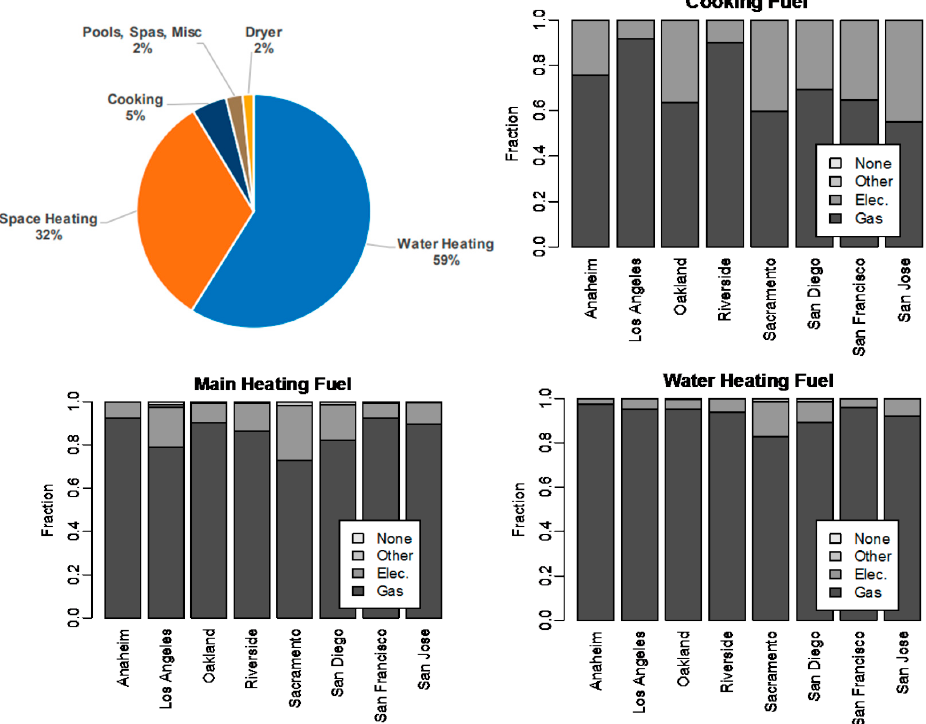
Figure 12. Energy-consumption status by residential appliances in California (U.S.)